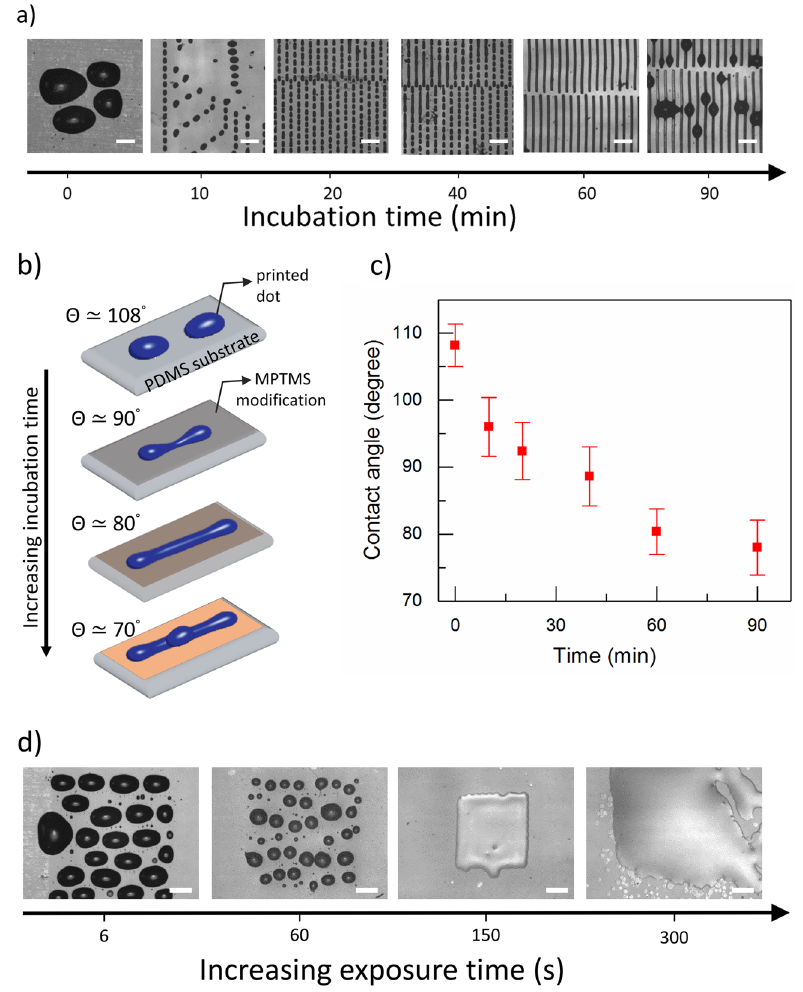
Fig. 2 Effect of MPTMS incubation on printed line formation. a Microscopic images of printed carbon lines with a fi xed drop spacing of 20 μm versus the incubation time of MPTMS, scale bars represent 200 μm. b Schematic drawing of the ink spreading on a PDMS substrate. c Measured contact angles of a water drop as a function of the incubation time of MPTMS. d Optical microscopy images of printed PI ink on PDMS as a function of oxygen plasma exposure time. The design of the structure to be printed was a rectangular shape as shown in the third image of this sequence. All structures were printed with a fi xed DPI (dots per inch) of 846. Scale bars represent 200